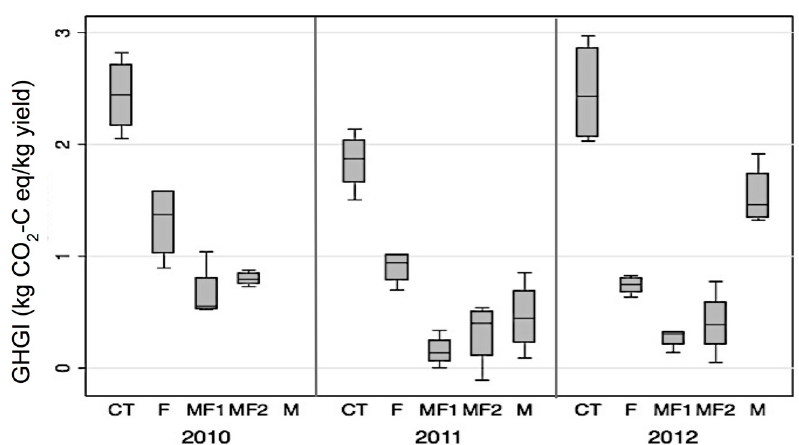
Figure 3. Greenhouse gas intensity (GHGI) in 2010–2012 (experiment 1). CT is unfertilized control plot; F is inorganic fertilizer ‐ only plot; MF1 is inorganic fertilizer plus composted cattle manure applied since 2005 plot; MF2 is inorganic fertilizer plus composted cattle manure applied since 2010 plot; M is composted cattle manure ‐ only plot.